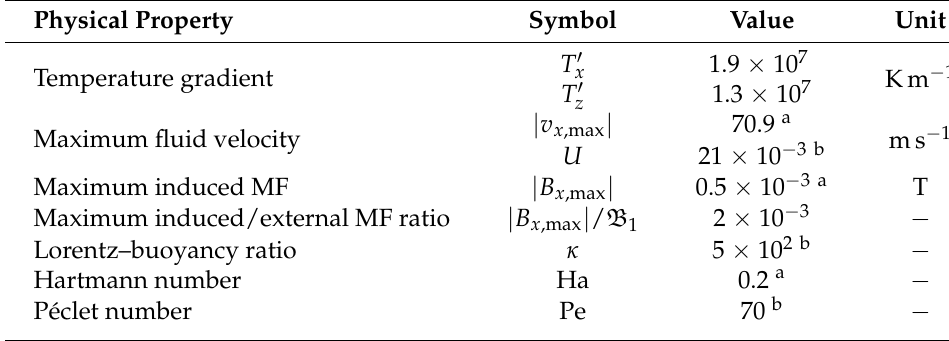
Table 3. The estimated quantities.